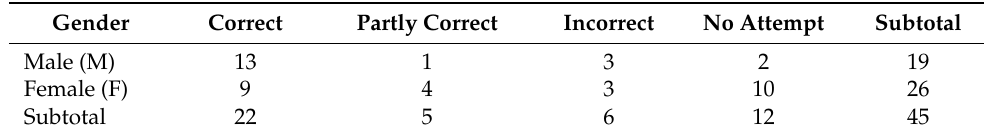
Table 11. Frequencies of student’s results and actions by gender groups.